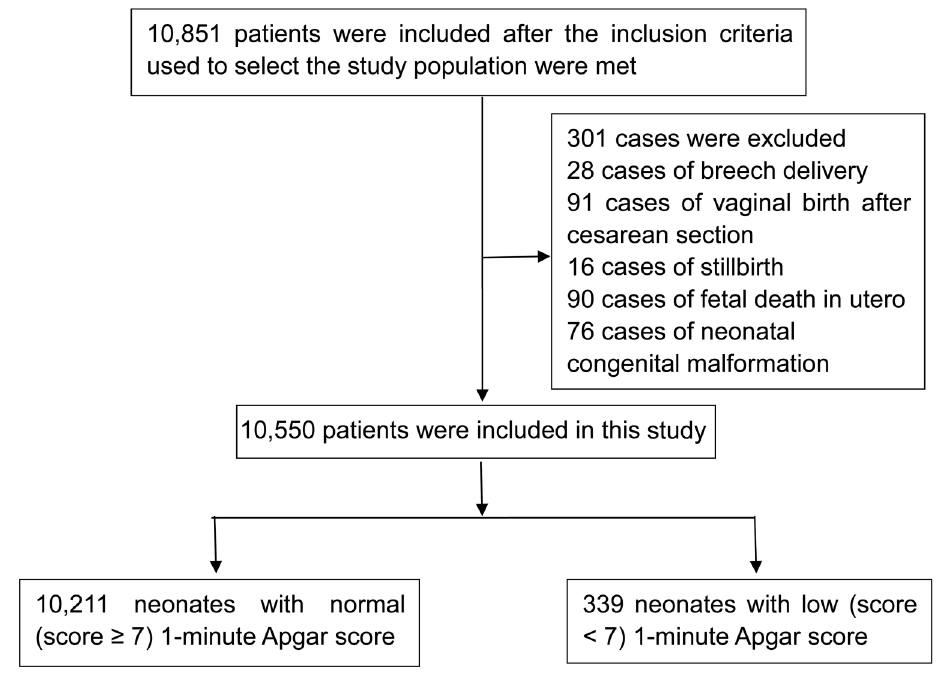
Figure 1. Flow-chart for patient selection